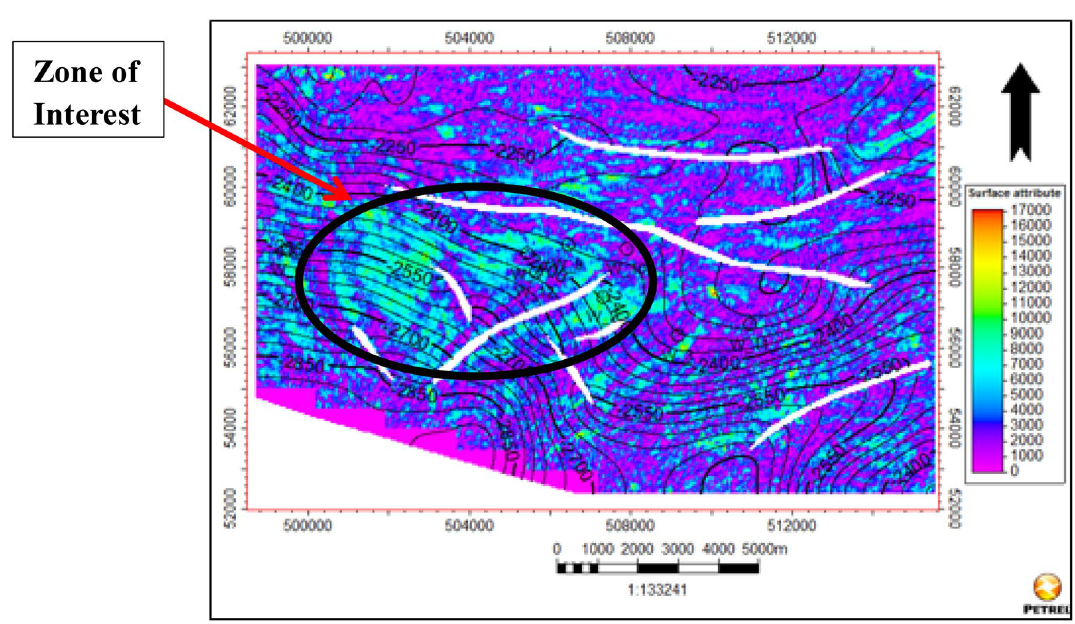
Fig. 9 Root mean square (RMS) amplitude attribute extracted on horizon 1